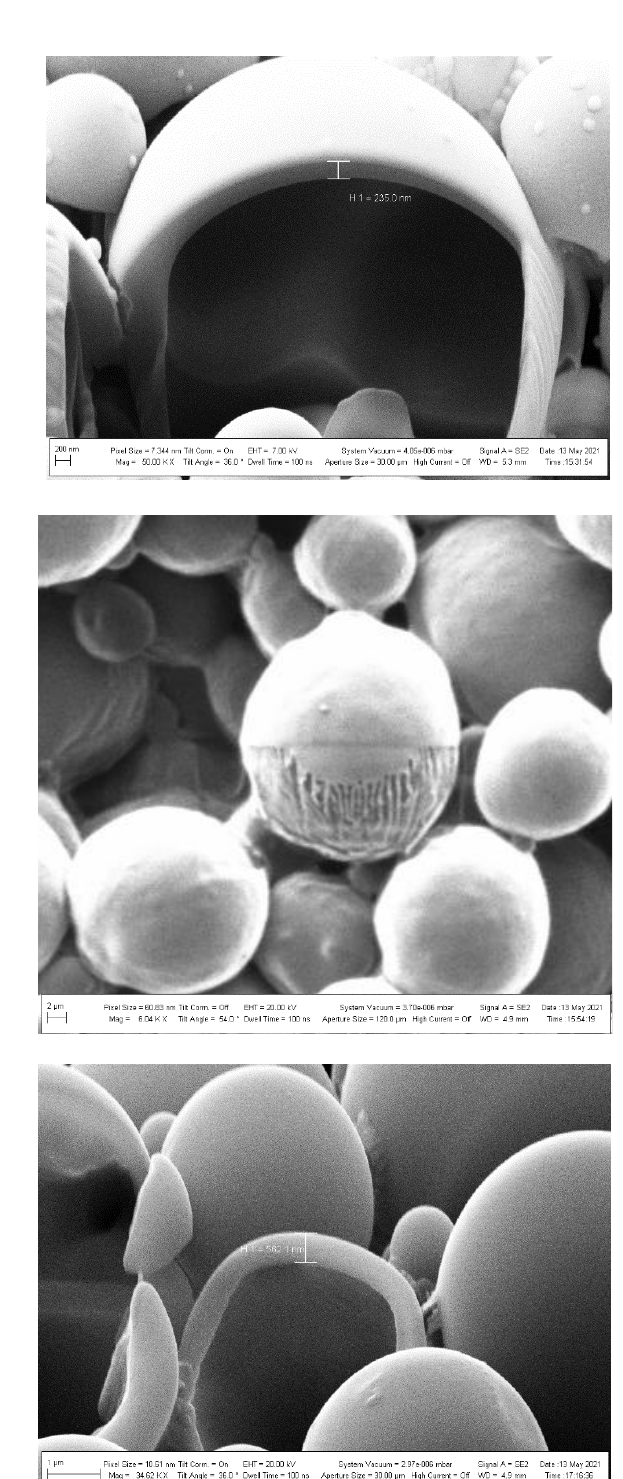
Figure 5. HR FE-SEM images of the cross-section of the three different MPs. PLGA: poly(lactic- co - glycolic acid), PCL: poly(ε -caprolactone), PLA: poly(lactic acid).